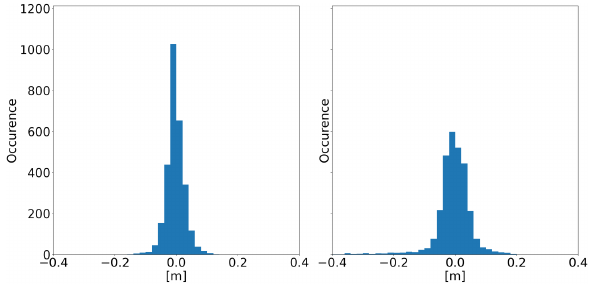
Figure 15. Distribution of the mean values of the consensus sets exceeding the 80 percent threshold along the x - and y